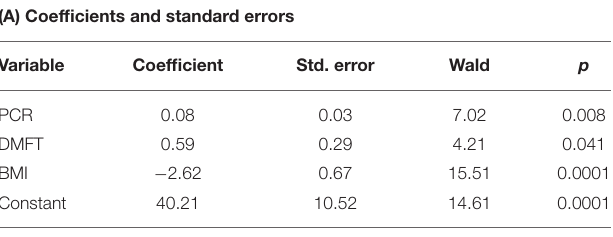
TABLES 3A and B | The logistic regression results indicated three variables: BMI, DMFT, and PCR. They turned out to be statistically significant at p < 0.05. (A) Coefficients and standard